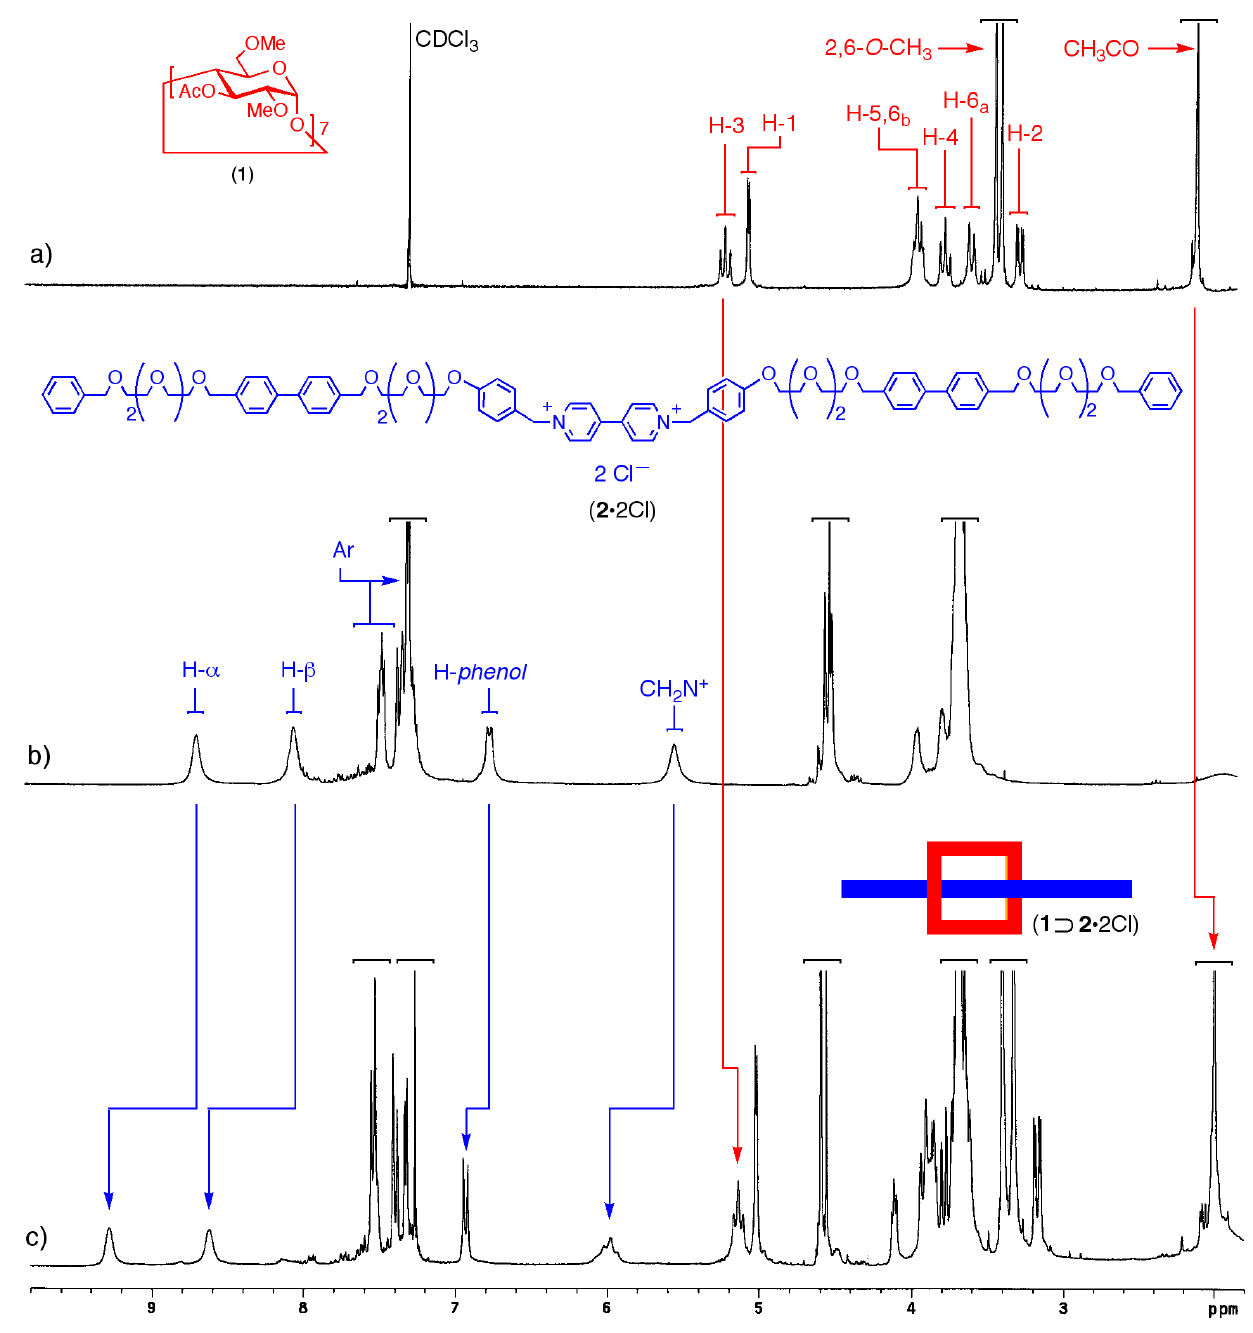
Figure 2 . 1 H NMR spectra (300 MHz, CDCl , 22 °C) of 5 mM samples of: a) cyclodextrin 1 ; 3 b) linear component 2 ⋅ 2Cl; c) [2]pseudorotaxane 1 ⊃ 2 ⋅